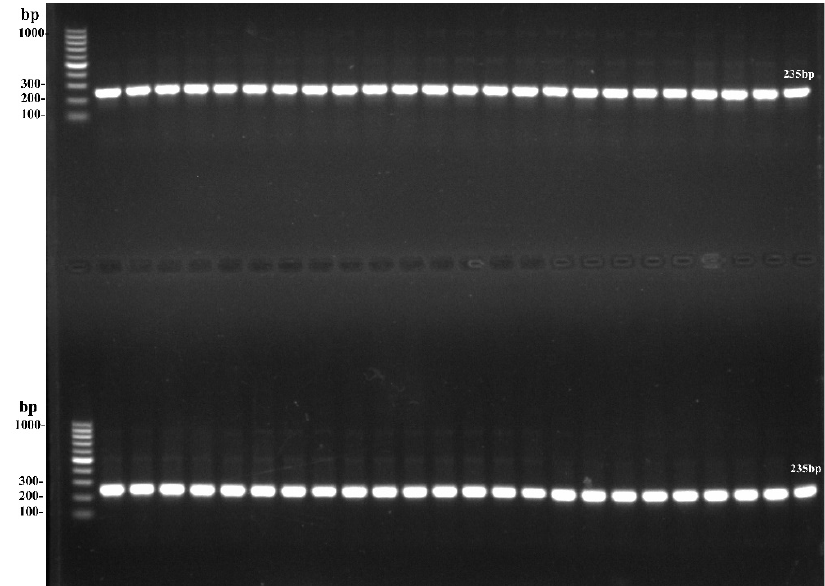
Figure 2. PCR amplification DNA of R. solani AG1-IA. Table 1. Sensitivity of SYP-32497 and fluxapyroxad to R. solani in China.